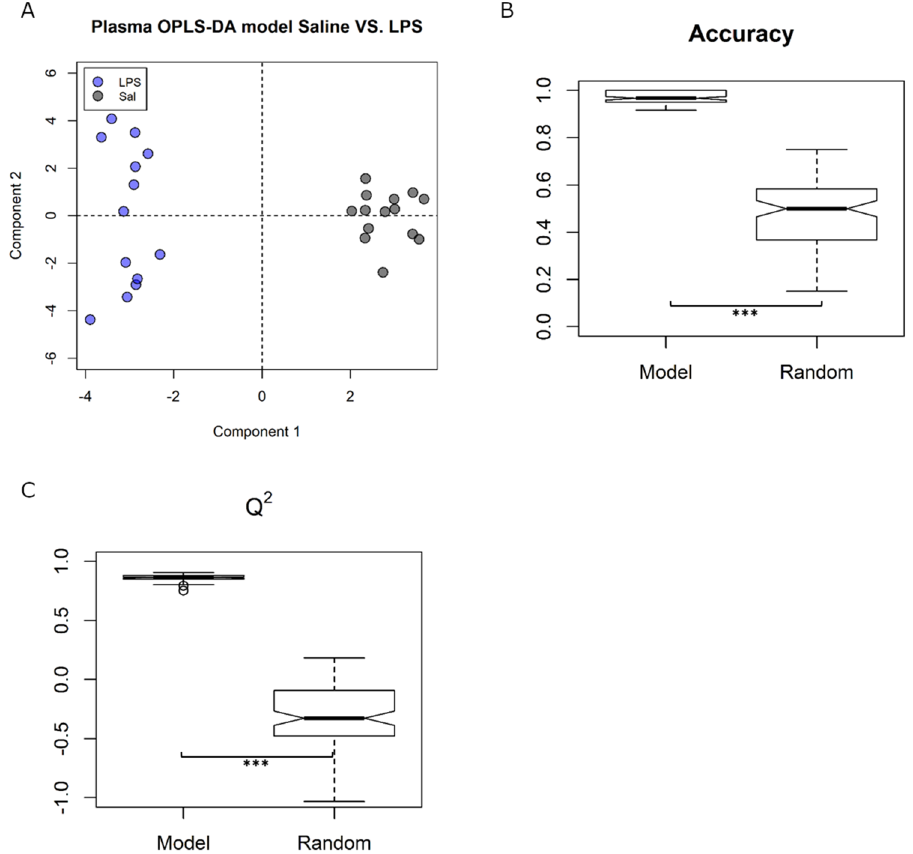
higher in the ensemble of Saline/LPS models compared to the null models with group labels randomly permuted. *** p < 0.001.